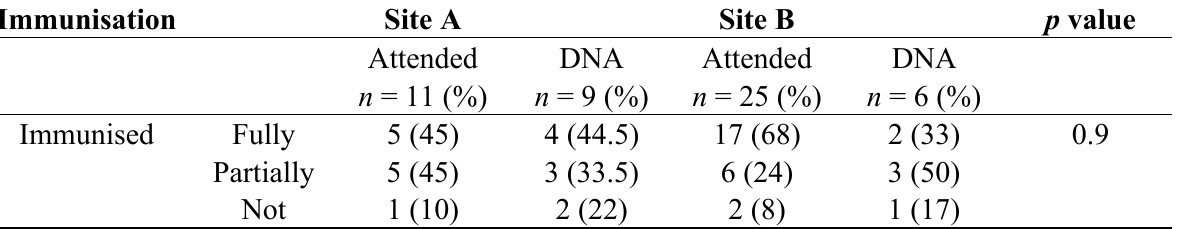
Table 3. Immunisation status of clinic attendees versus non-attendees.